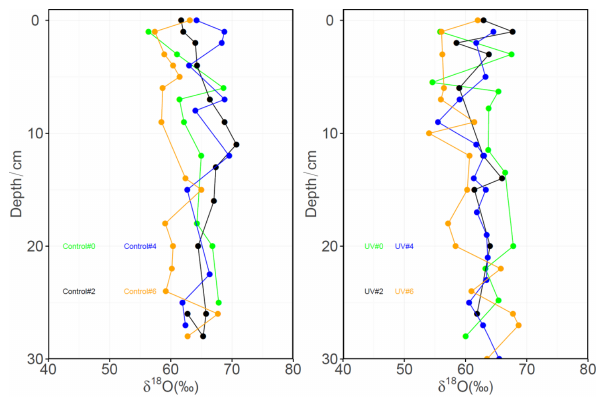
Figure 7. δ 18 O depth profiles for snow nitrate in the control (left panel) and UV (right panel) pits.